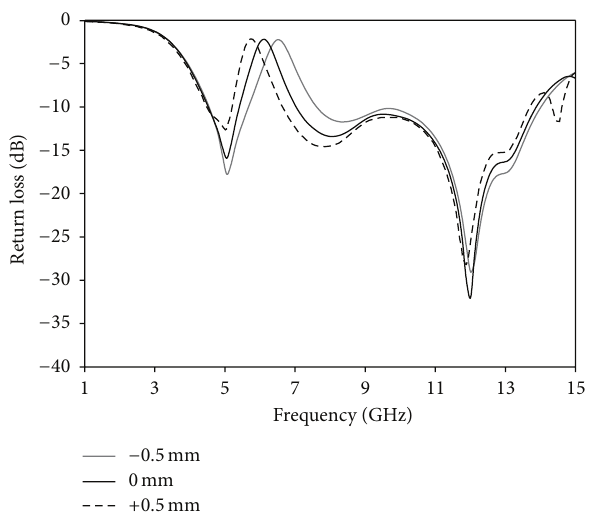
Figure 8: Effects on return loss with changing arm length.